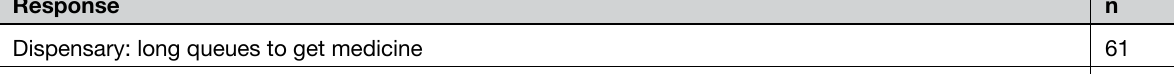
Table 2: Number of responses to what caregivers liked least about the service (n=303)